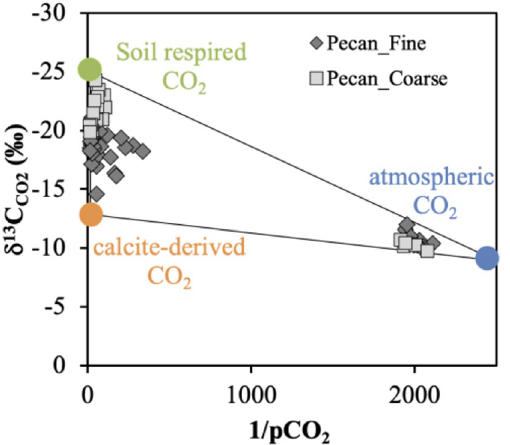
Figure 2. Keeling plot shows soil CO 2 is contributed by three endmember mixing (atmospheric, soil respired and calcite-derived abiotic) in two soil profiles. Pecan_Fine has finer soil texture and higher calcite content than Pecan_Coarse, and soil CO 2 in Pecan_Fine receives more calcite-derived abiotic CO 2 contribution. Pecan_ Coarse soils support larger trees and so, produce more soil respired CO 2 . The atmospheric δ 13 C CO2 is − 8.9‰ 43